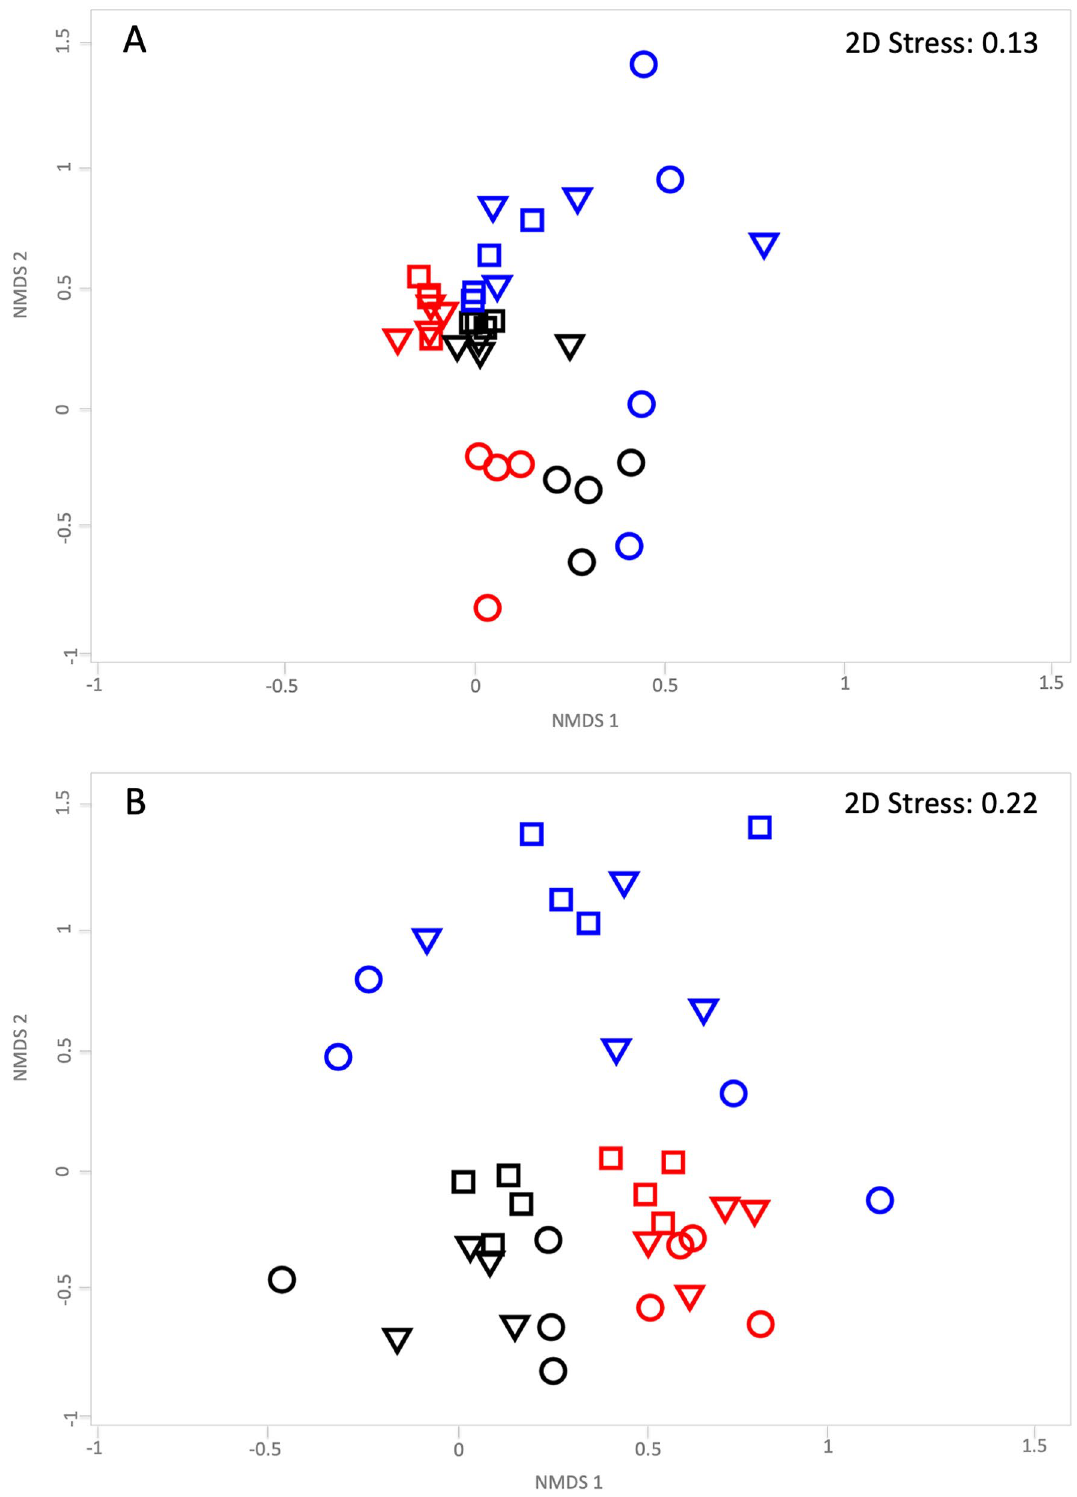
Figure 1. Non-metric multidimensional scaling (NMDS) analysis of Hha I-terminal restriction fragment length polymorphisms (T-RFLP) profiles of metagenomic DNA from three soil substrates. T-RFLP profiles of 16S rRNA bacterial (A) and internal transcribed spacer fungal (B) community sequences were obtained from the rhizoplane (circles), rhizosphere (triangles), and non-rhizosphere (squares) of Huana tailings (red symbols), Tambillos tailings (blue symbols) and surrounding soil (black symbols). Each symbol corresponds to a single T-RFLP profile (four samples each site). Stress values for NMDS analysis are shown in each upper right corner. This image was created using Primer v6 software, URL https:// www. primer- e.